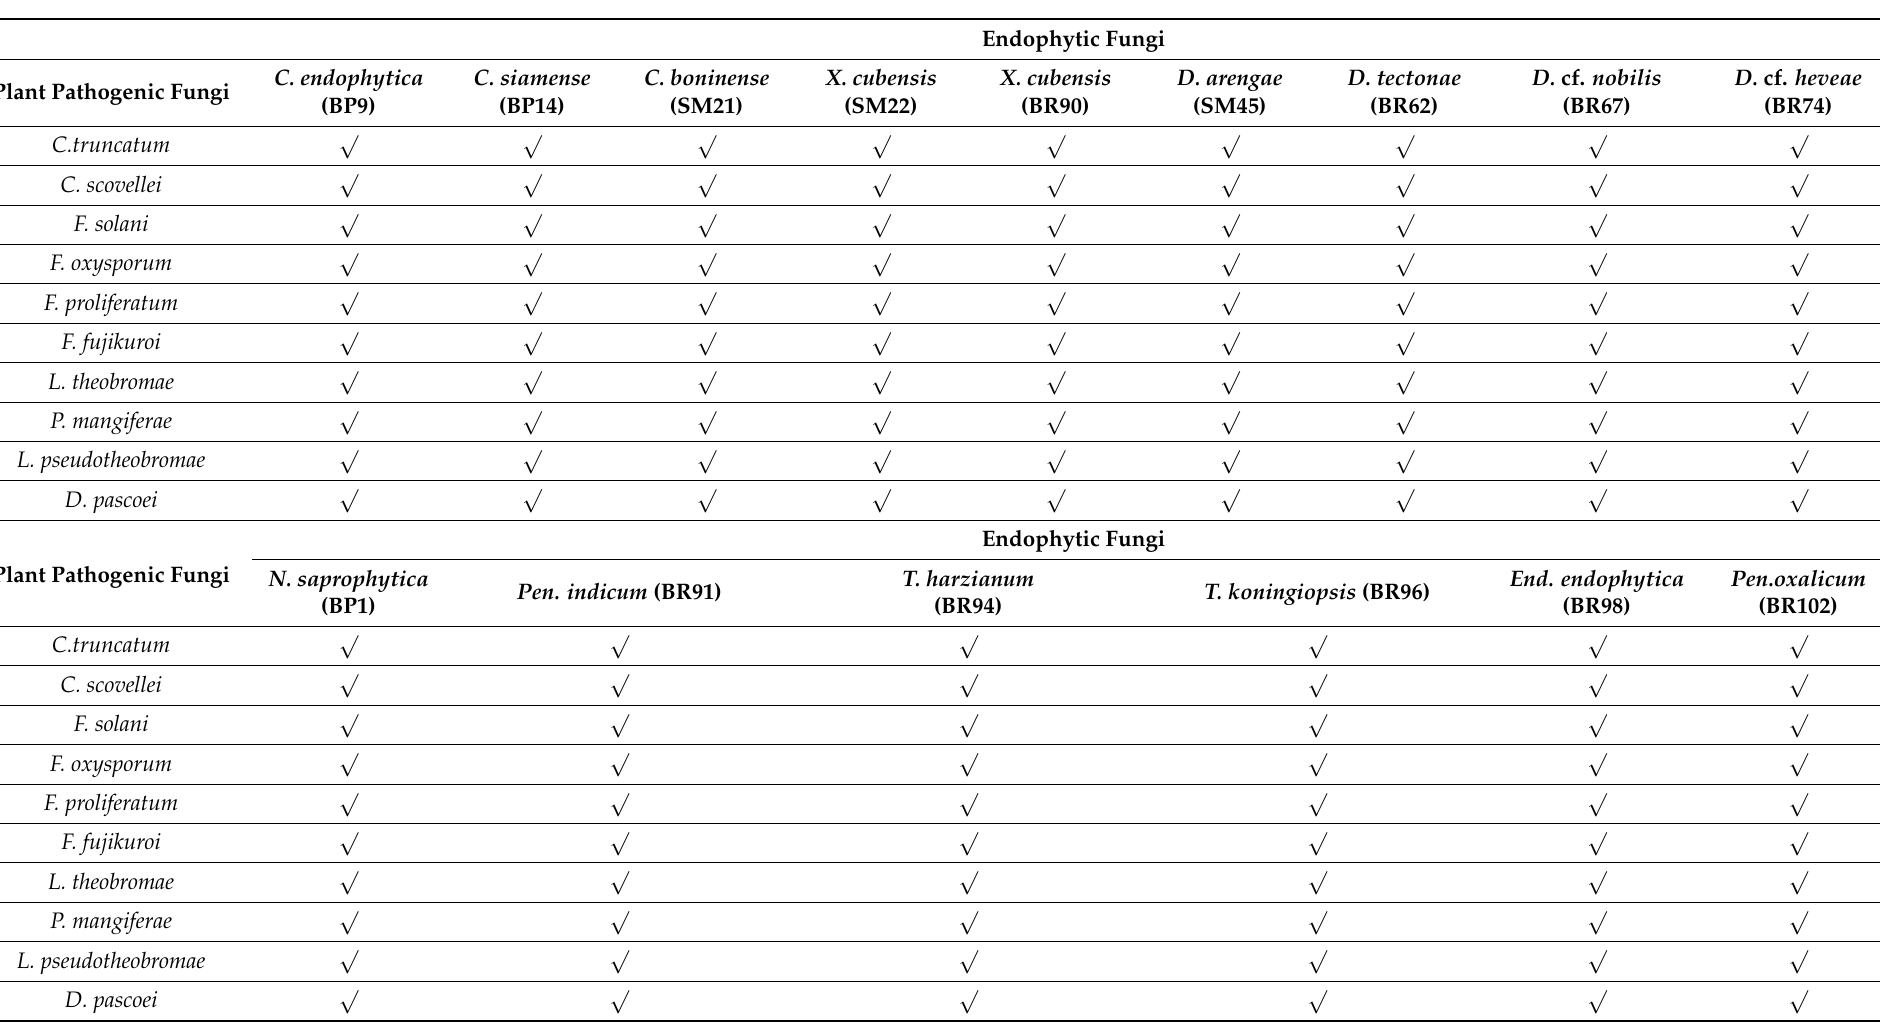
Table 2. Combination of endophytic fungi and plant pathogenic fungi tested in dual culture